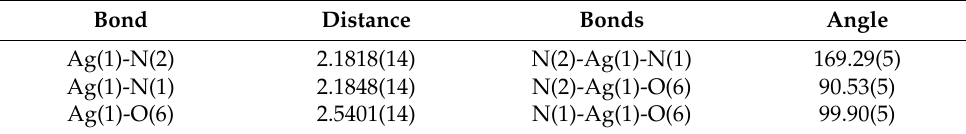
Table 2. Bond lengths (Å) and angles ( ◦ ) for the [Ag(Et3qu)2(citrate)] complex.